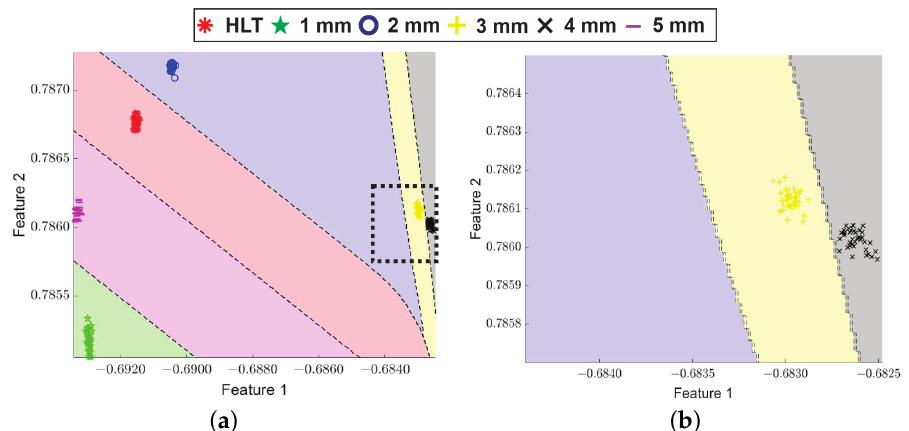
Figure 10. Projection of the decision regions for the multiple fault classification computed by the proposed FFNN-based classifier when the induction motor is driven at 60 Hz under a direct start: